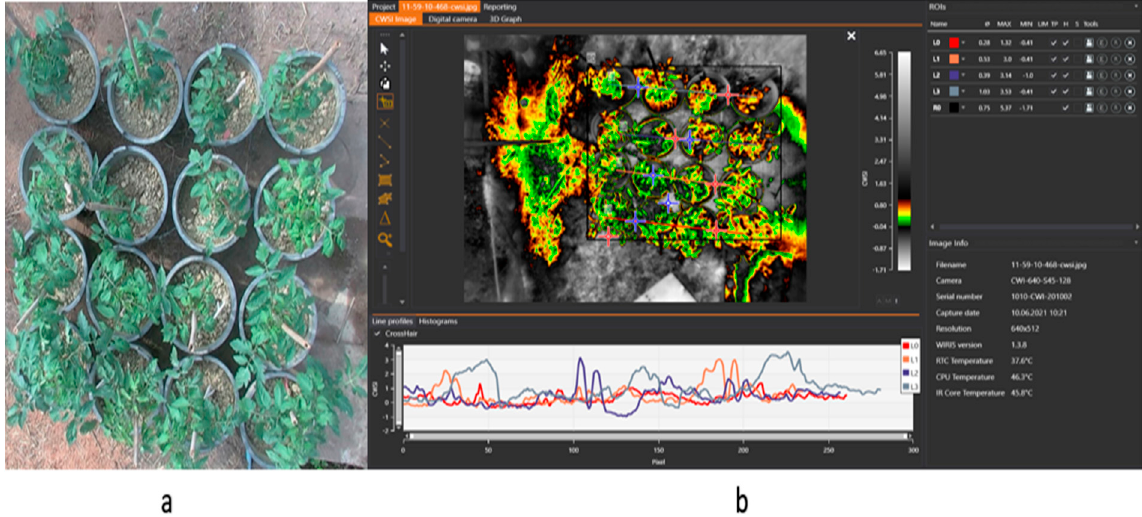
Figure 8. ( a ) Digital image of the tomato plant ( b ) isotherm panel with the map panel and ROI panel reveals the tomato plant’s thermal data for mapping water stress.